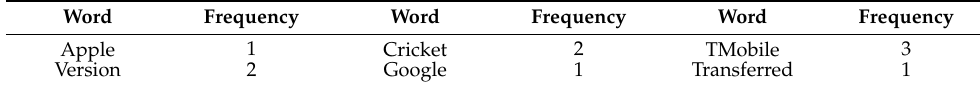
Table 14. Named-entity recognition results from the coordinating relationship.